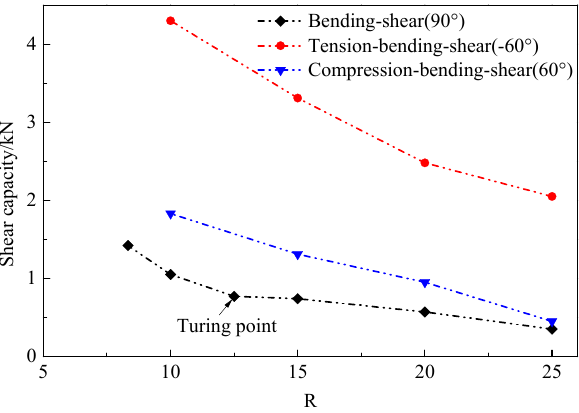
Figure 8. Degradation curves of shear capacity.